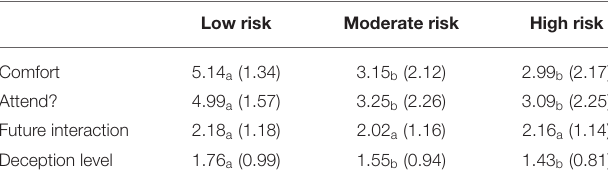
TABLE 1 | Means and standard deviations by riskiness of scenario.